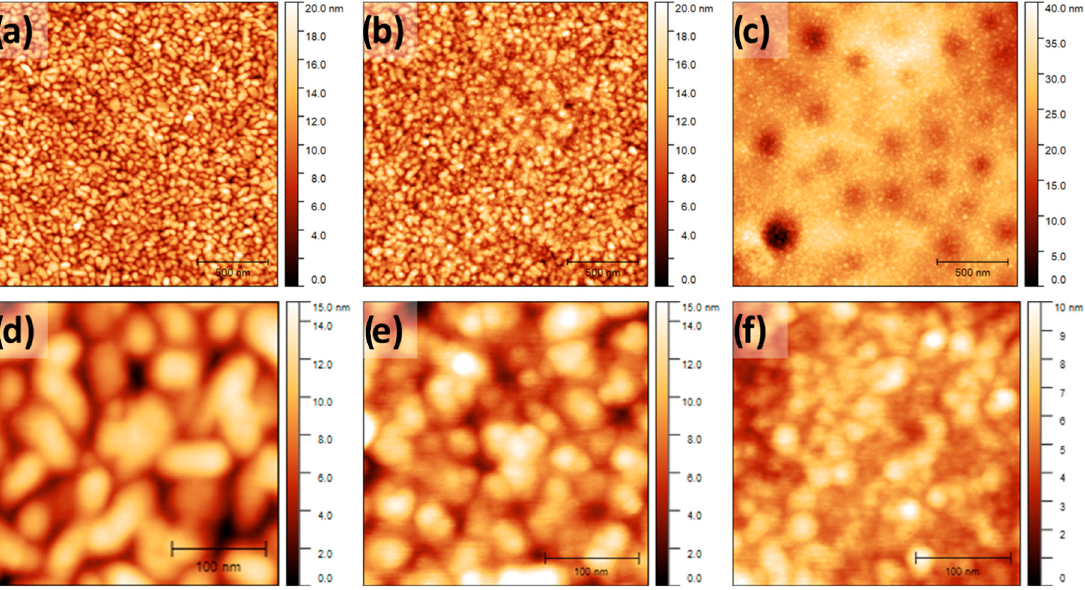
Figure 1. Atomic force microscopy (AFM) topographic images of 2 µm × 2 µm ( a – c ) and 0.6 µm × 0.6 µm ( d – f ) for bare polycrystalline gold substrate ( a , d ), monolayer of micelles ( b , e ) and multilayer of micelles ( c , f ).